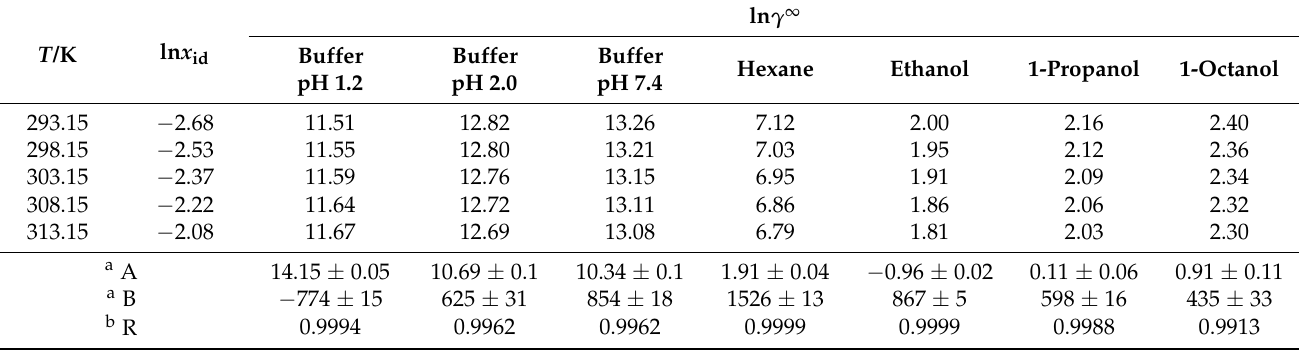
Table 6. Temperature dependences of ideal solubility (ln x id ) and activity coefficients at infinite dilution (ln γ ∞ ) of IVZ in the studied solvents at p = 101.3